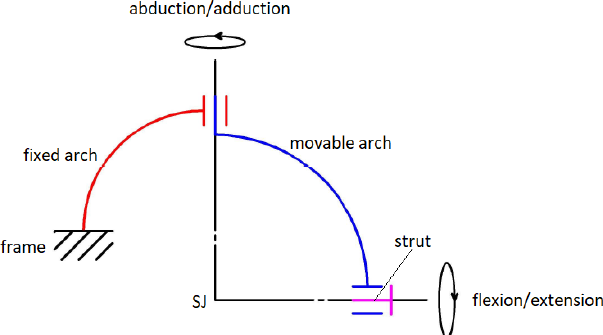
Figure 6. Diagram of the universal joint in the frontal plane; SJ represents the center of the glenohumeral